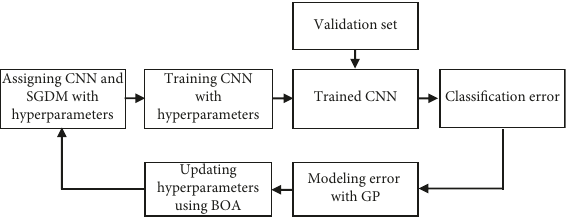
Figure 4: Block diagram of optimizing HPs using